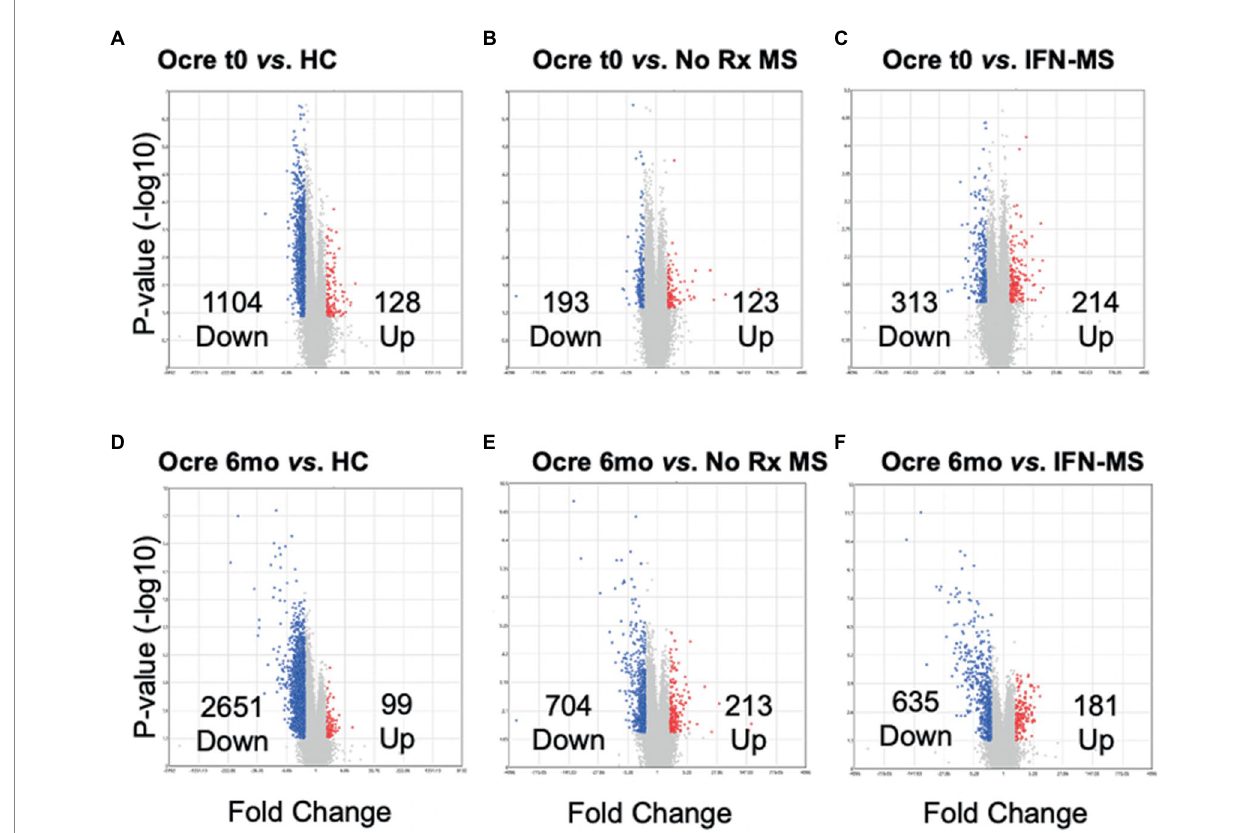
FIGURE 1 Differentially expressed genes (DEG) in PBMC from 15 MS patients at time 0 and 6 months after ocrelizumab infusion, compared to HC, therapy-naïve (No Rx) MS, and IFN- β -treated MS. (A) 15 ocrelizumab-treated MS at time 0 have more genes with decreased expression than 10 HC, (B) 10 therapy- naïve MS, and (C) 9 IFN- β -treated MS. Ocrelizumab-treated MS at 6 months have decreased gene expression compared to (D) HC, (E) therapy-naïve MS, and (F) IFN- β -treated MS. Red indicates genes upregulated; blue indicates genes decreased in ocrelizumab-treated compared to other groups. Uncharacterized, AceView-identified, genes (gray) excluded from analysis even if fold-change is